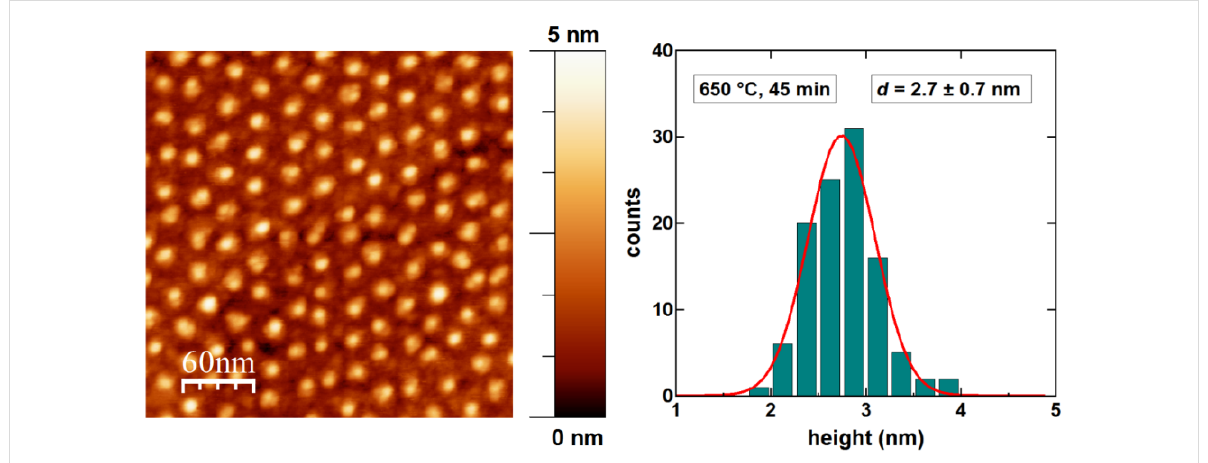
Figure 10: AFM image and height histogram of 2–3 nm FePt nanoparticles on MgO(001) after annealing at 650 °C for 45 min. The particles are well separated in a hexagonal arrangement. The height histogram shows the size distribution centered at 2.7 nm.